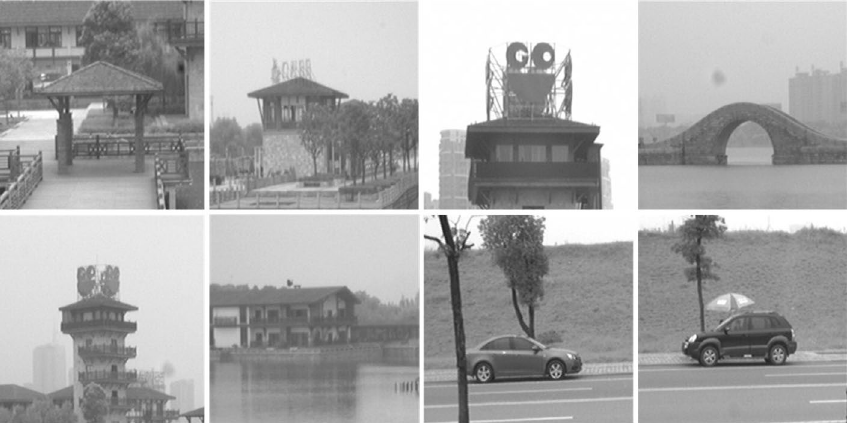
Fig. 12. 256 256 pixel real-time visible ×